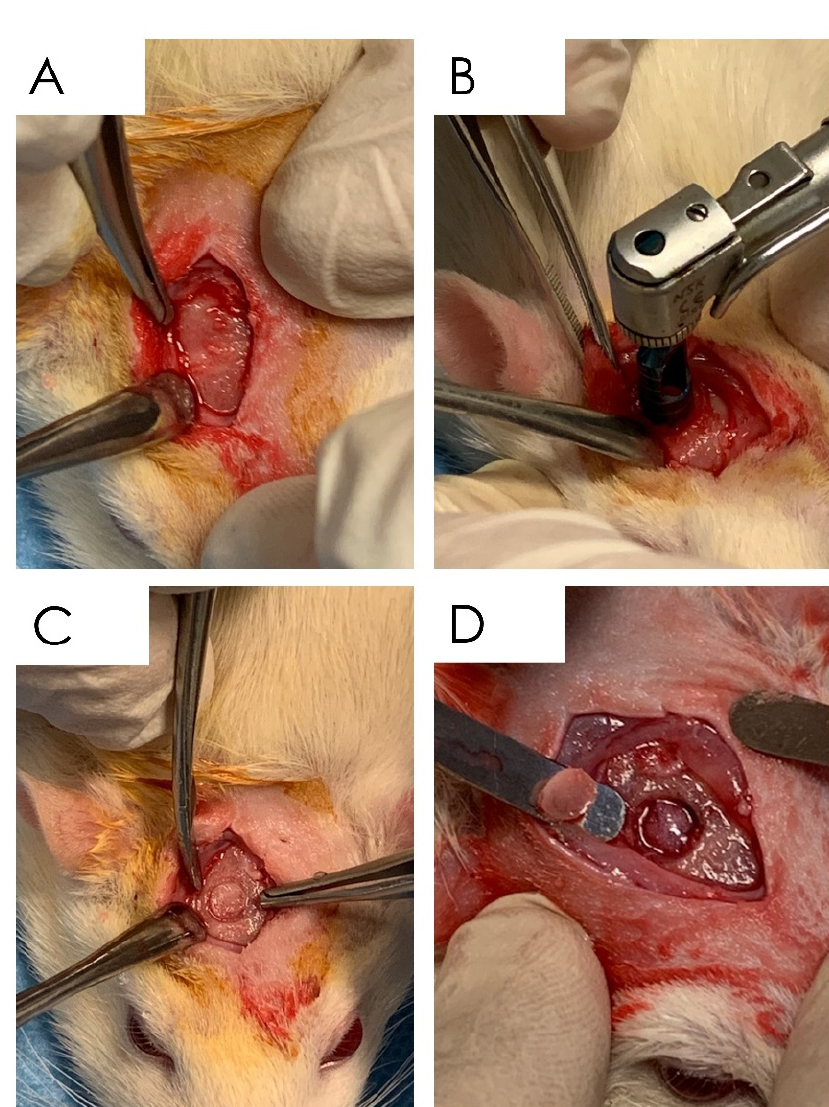
Figure 1. Surgical phases of the in vivo experiment: ( A ) exposure of the calvarial surface through a full-thickness incision; ( B ) drilling of the cortical surface of the calvaria through the 5 mm trephine bur; ( C ) details of the site after the osteotomy; ( D ) cortical layer removal. Concentration and solution preparation was performed following a previously described method by Correa et al. [40,41,44]. The resveratrol solution was prepared in 100